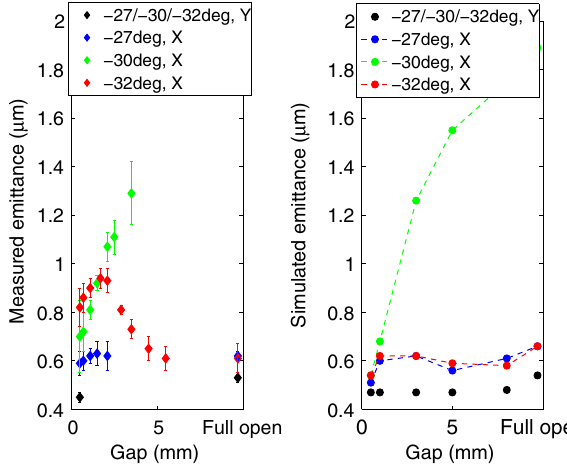
FIG. 9. Measured (left) and simulated (right) emittance vs collimator gap for different amounts of bunch compression. The L1S phase of − 27 °, − 30 ° and − 32 ° corresponds to under compression , full compression and overcompression,